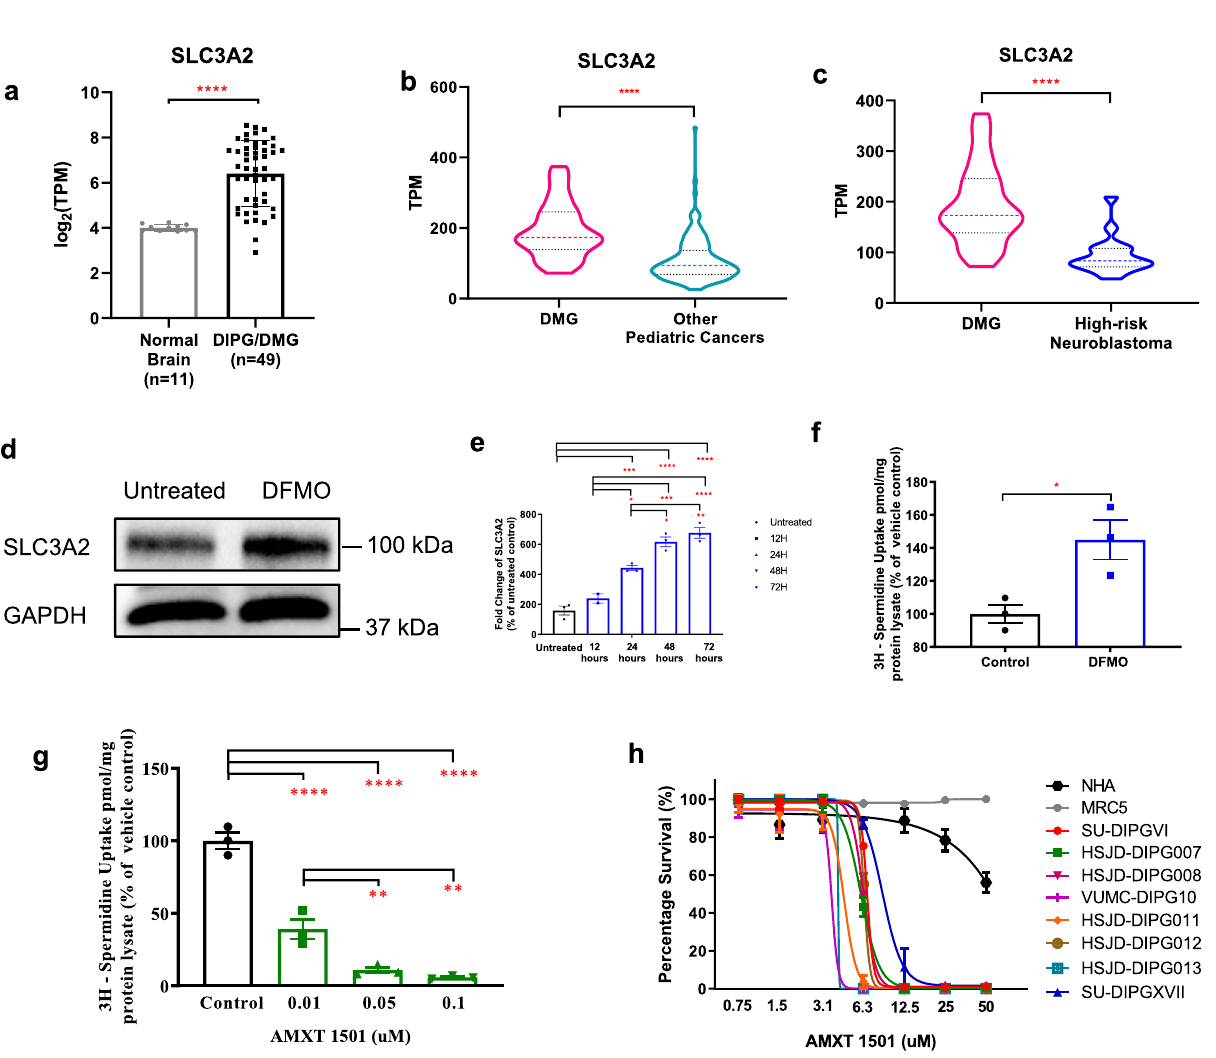
Fig. 2 Polyamine transporter expression in pediatric DIPG brain tumors. Expression of polyamine transporter SLC3A2 in ( a ) DIPG tumors ( n = 49) compared to normal fetal brain ( n = 11) ( p < 0.0001). Data were obtained from ZCC/PRISM Clinical trial and McGill University 30 . b – c Examination of RNA expression levels in a cohort of high-risk childhood cancers showed that the polyamine transporter, SLC3A2, was signi fi cantly overexpressed in DMG ( n = 28) compared with high-risk childhood cancers ( n = 148) ( p < 0.0001) and neuroblastoma ( n = 17) ( p < 0.0001). Treatment of HSJD-DIPG007 cells with 40 mM DFMO leads to increased SLC3A2 ( d ) protein and ( e ) gene expression, resulting in ( f ) increased uptake of radiolabeled spermidine ( p = 0.0276). g Polyamine transport inhibition by AMXT 1501 decreased uptake of radiolabeled spermidine and ( h ) was cytotoxic against patient-derived DIPG cell lines. Data are presented as mean values± SEM of three independent experiments. * p < 0.05, ** p < 0.01, *** p < 0.001, **** p < 0.0001. a , b , c , f Statistical analysis was calculated using two-tailed t tests between sample cohorts. e , g Statistical analysis was calculated using one-way ANOVA between cohorts and for treated and untreated samples. e UT vs 24 h: p = 0.0005, UT vs 48 h: p < 0.0001, UT vs 72 h: <0.0001, 12 h vs 24 h: p = 0.0107, 12 h vs 48 h: p = 0.0001, 12 h vs 72 h: p < 0.0001, 24 h vs 48 h: p = 0.0142, 24 h vs 72 h: p = 0.0021. g Control vs 0.01: p < 0.0001, Control vs 0.05: p < 0.0001, Control vs 0.01: p < 0.0001, 0.01 vs 0.05: p = 0.0092. 0.01 vs 0.1: p =